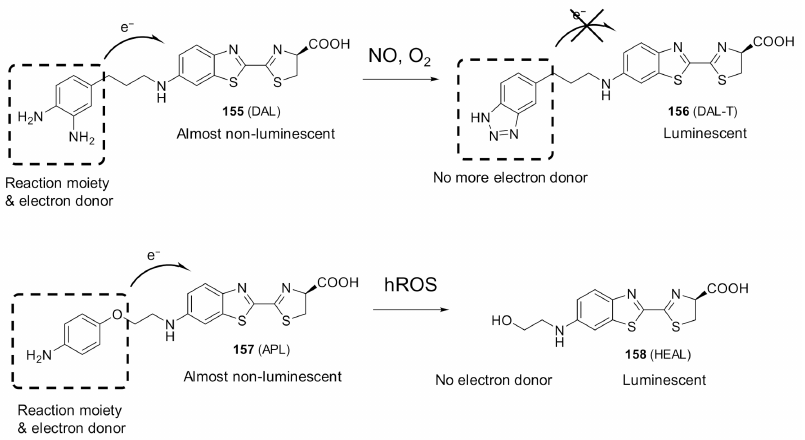
Figure 11. Chemical structures of bioluminescence probes based on bioluminescent-enzyme induced electron transfer